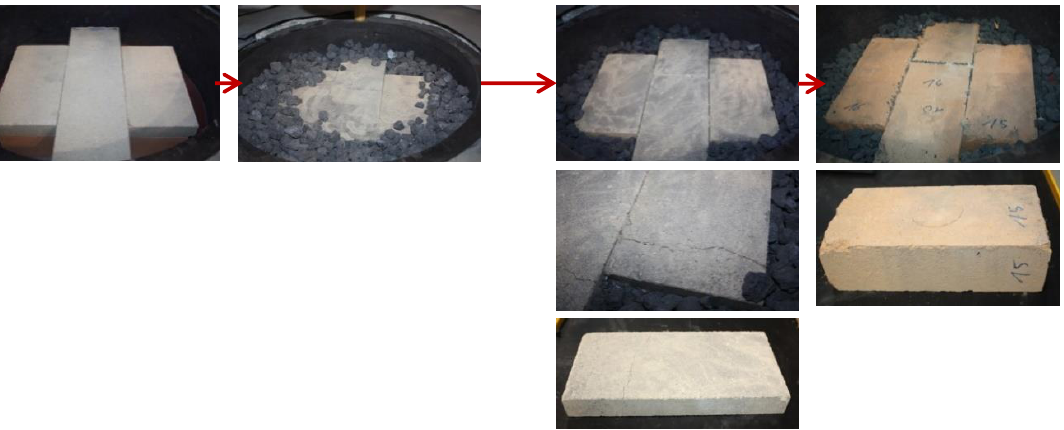
Figure 16. UCT of perlite brick insulation protected with super-duty firebricks.